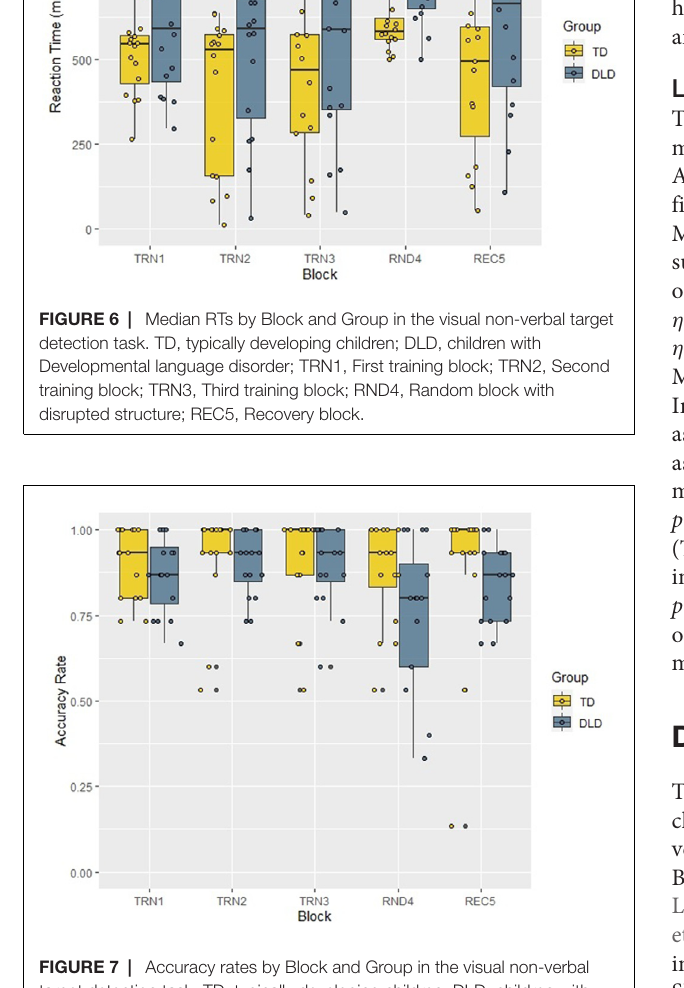
FIGURE 7 | Accuracy rates by Block and Group in the visual non-verbal target detection task. TD, typically developing children; DLD, children with Developmental language disorder; TRN1, First training block; TRN2, Second training block; TRN3, Third training block; RND4, Random block with disrupted structure; REC5, Recovery block.